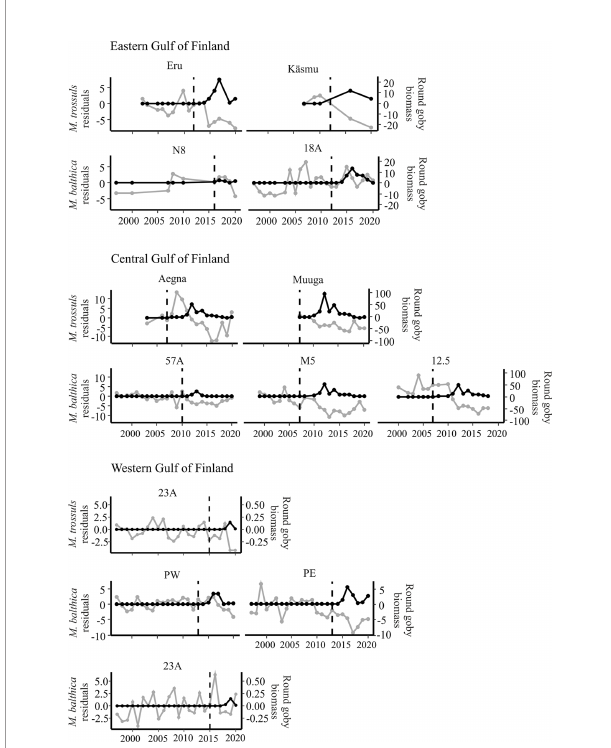
FIGURE 3 | Annual residuals (grey) (g dry weight m -2 ) and round goby biomass (black) (annual kg km -2 ) at stations in the Gulf of Finland. Dashed vertical line indicates start of round goby invasion in each station.